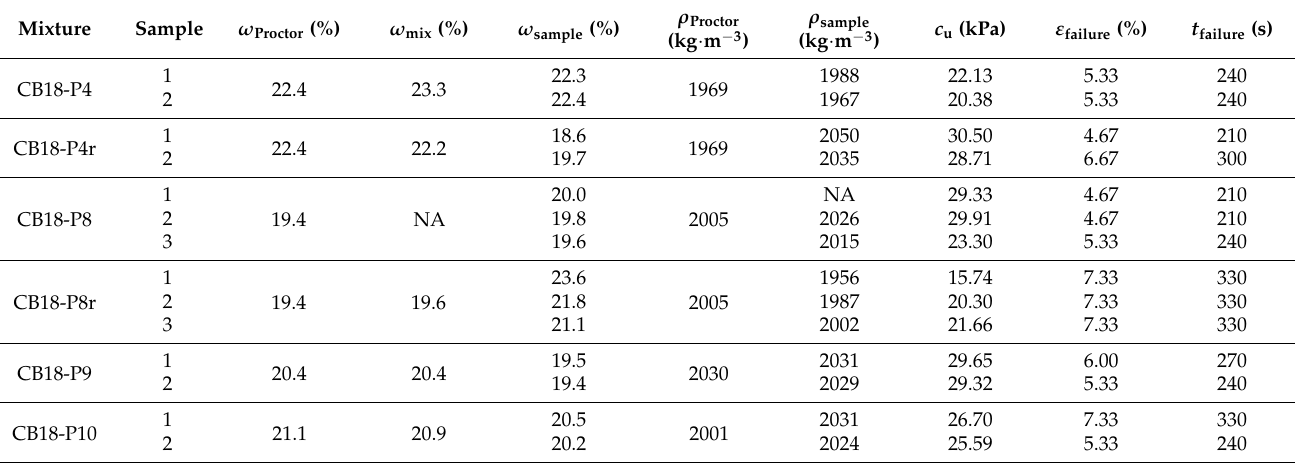
Table 6. Summary of the Simple Compression Tests (Phase I). The subscript ‘r’ stands for ‘repeated’ and NA for ‘Not Available’.